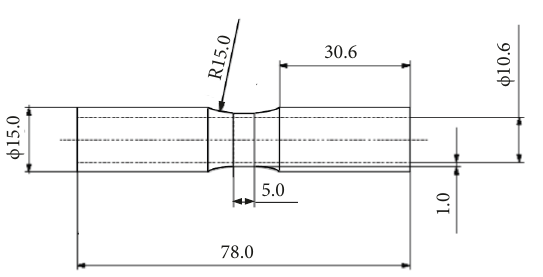
Figure 2: Sketch of the multiaxial specimen (unit: